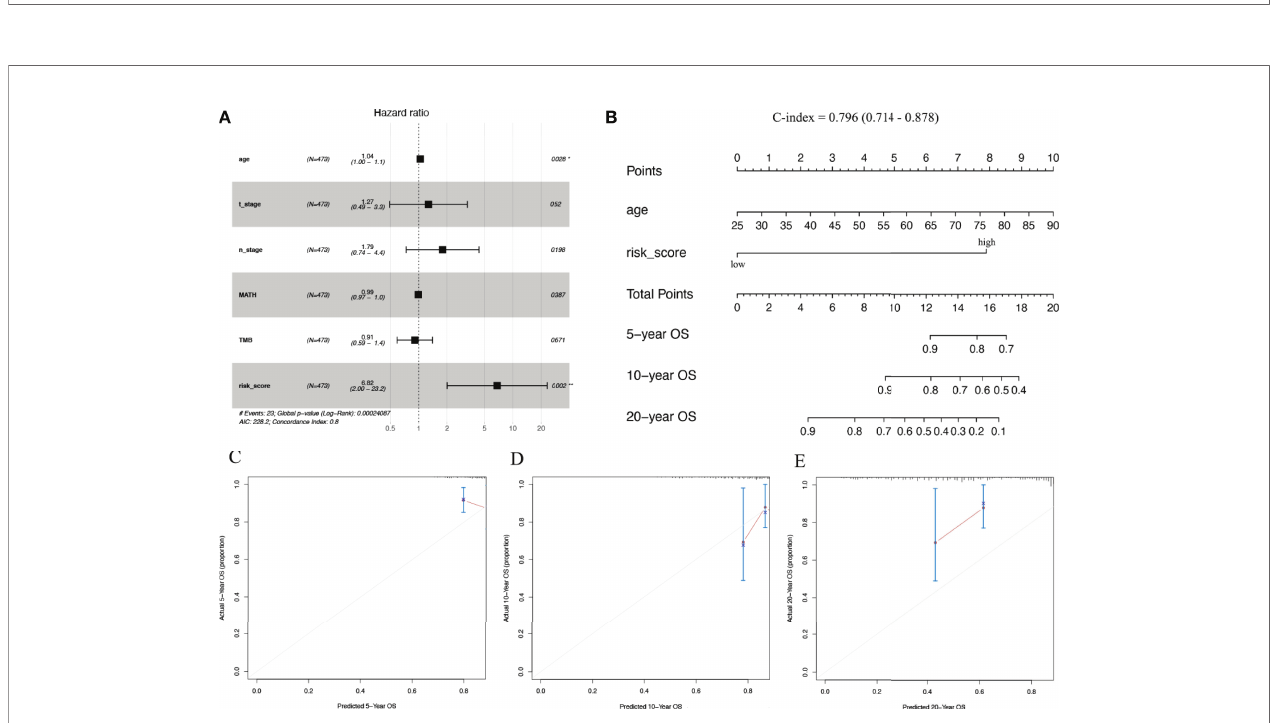
FIGURE 6 | Subgroup analysis of risk score predictive ability. (A – F) TCGA training cohort. (G – L) SCHI validation cohort. (A, G) AJCC stage I-II. (B, H) AJCC stage III. (C, I) pT1-2. (D, J) pT3-4. (E, K) pN1. (F, L)